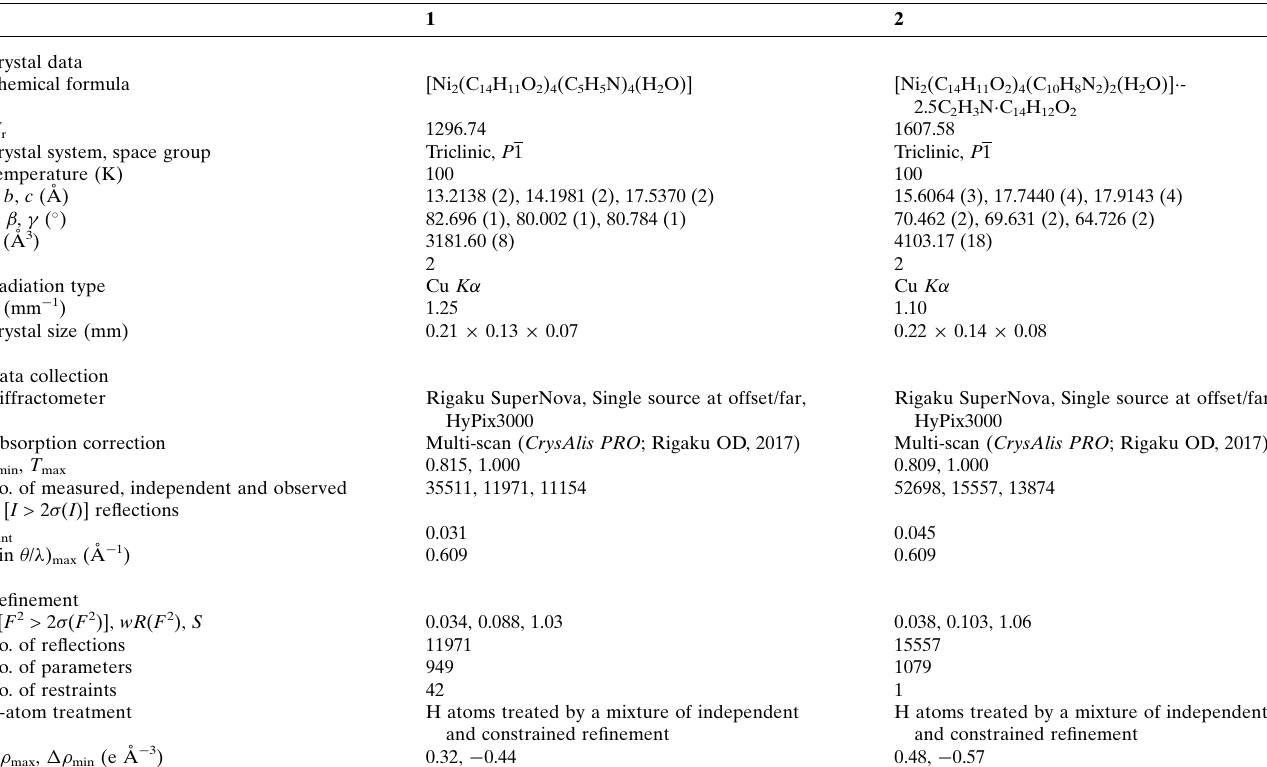
Table 3 Experimental